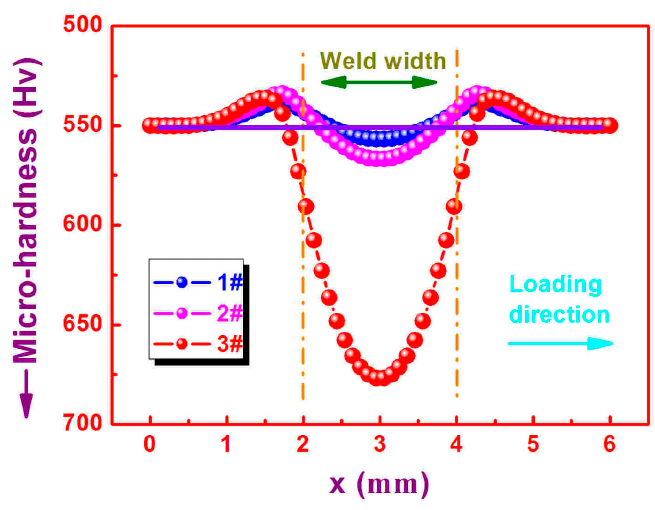
Figure 10. The simulated micro-hardness distributions along transverse direction in the welds and their both side areas.